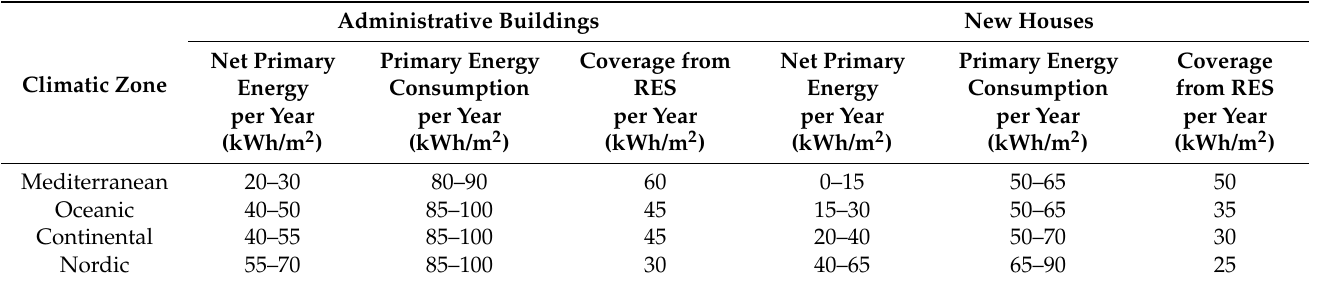
Table 1. Reference values for EPB with NZEB for different climate zones in the EU.